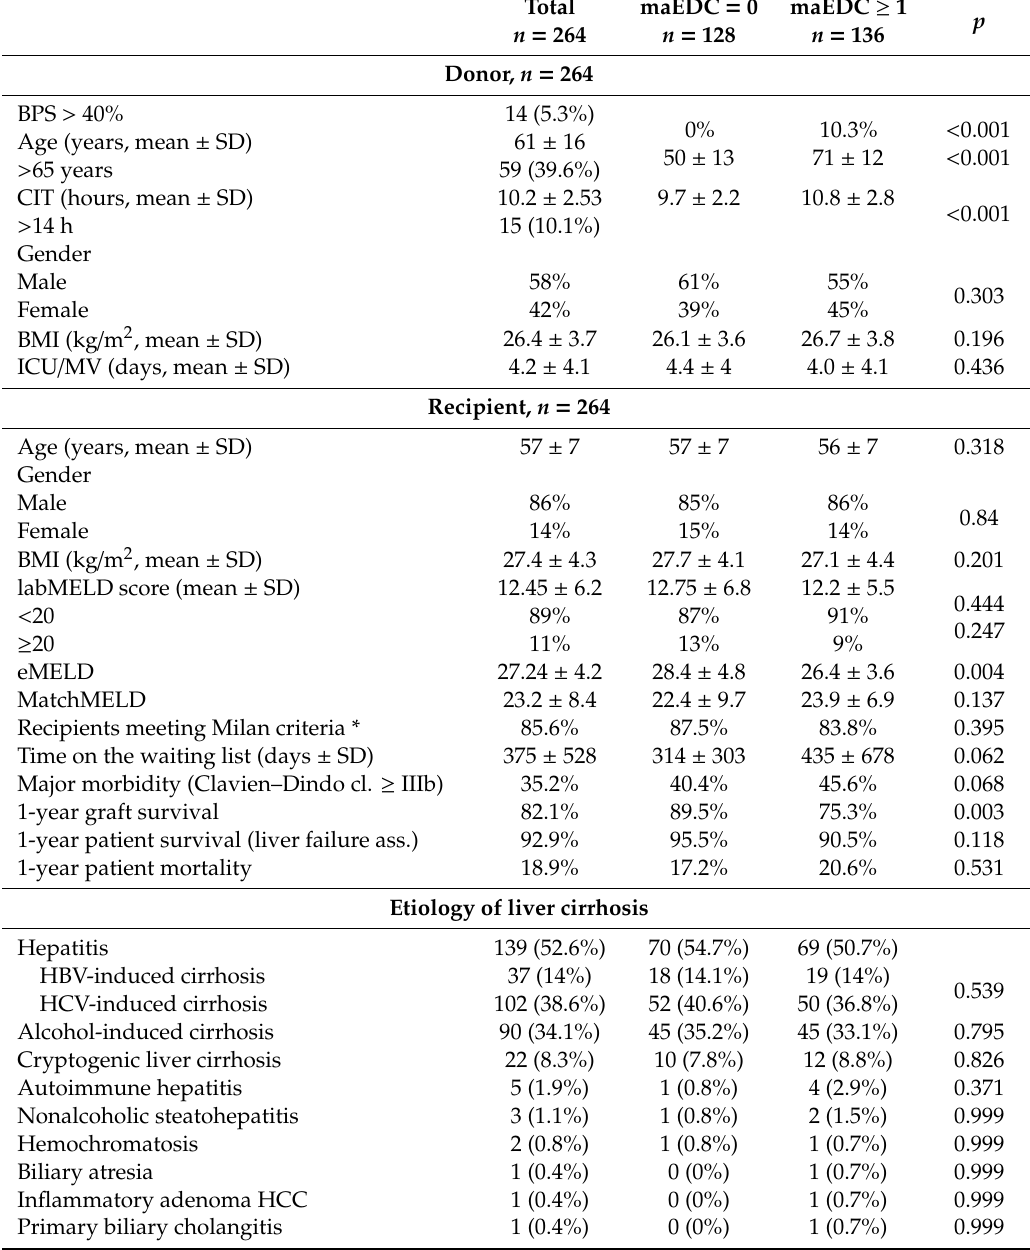
Table 1. Demographic characteristics, clinical parameters of the donor and recipient collective, etiology of liver cirrhosis, and comparison of no major extended donor criteria (maEDC) organ recipients and recipients of grafts with ≥ 1